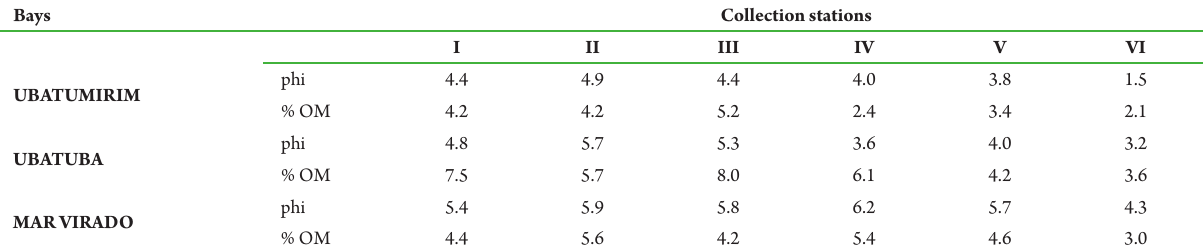
Table 1. Mean values of sediment parameters (φ and % OM) sampled from January 1998 to December 1999, at each sampling station, in the bays of Ubatumirim, Ubatuba and Mar Virado.